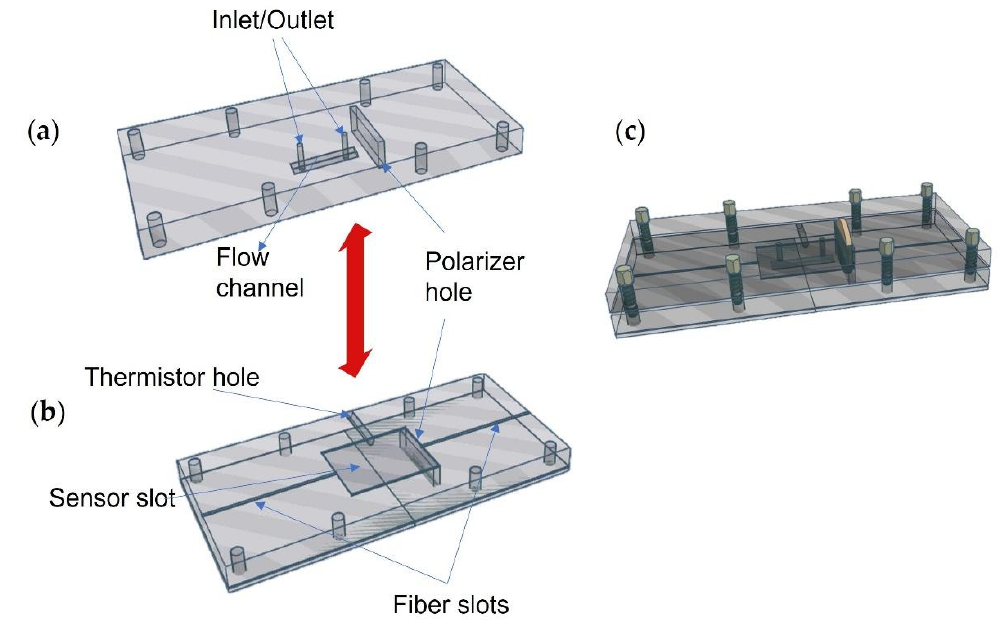
Figure 4. Schematic representation of the PMMA flow cell parts: ( a ) flow cell top, ( b ) flow cell bottom, and ( c ) screwed top and bottom parts with polarizer inside .